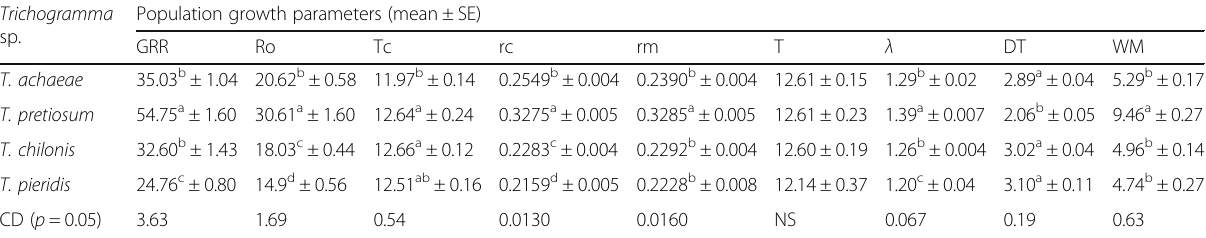
Table 2 Comparison of population growth parameters of Trichogramma spp. parasitizing Tuta absoluta in tomato Trichogramma